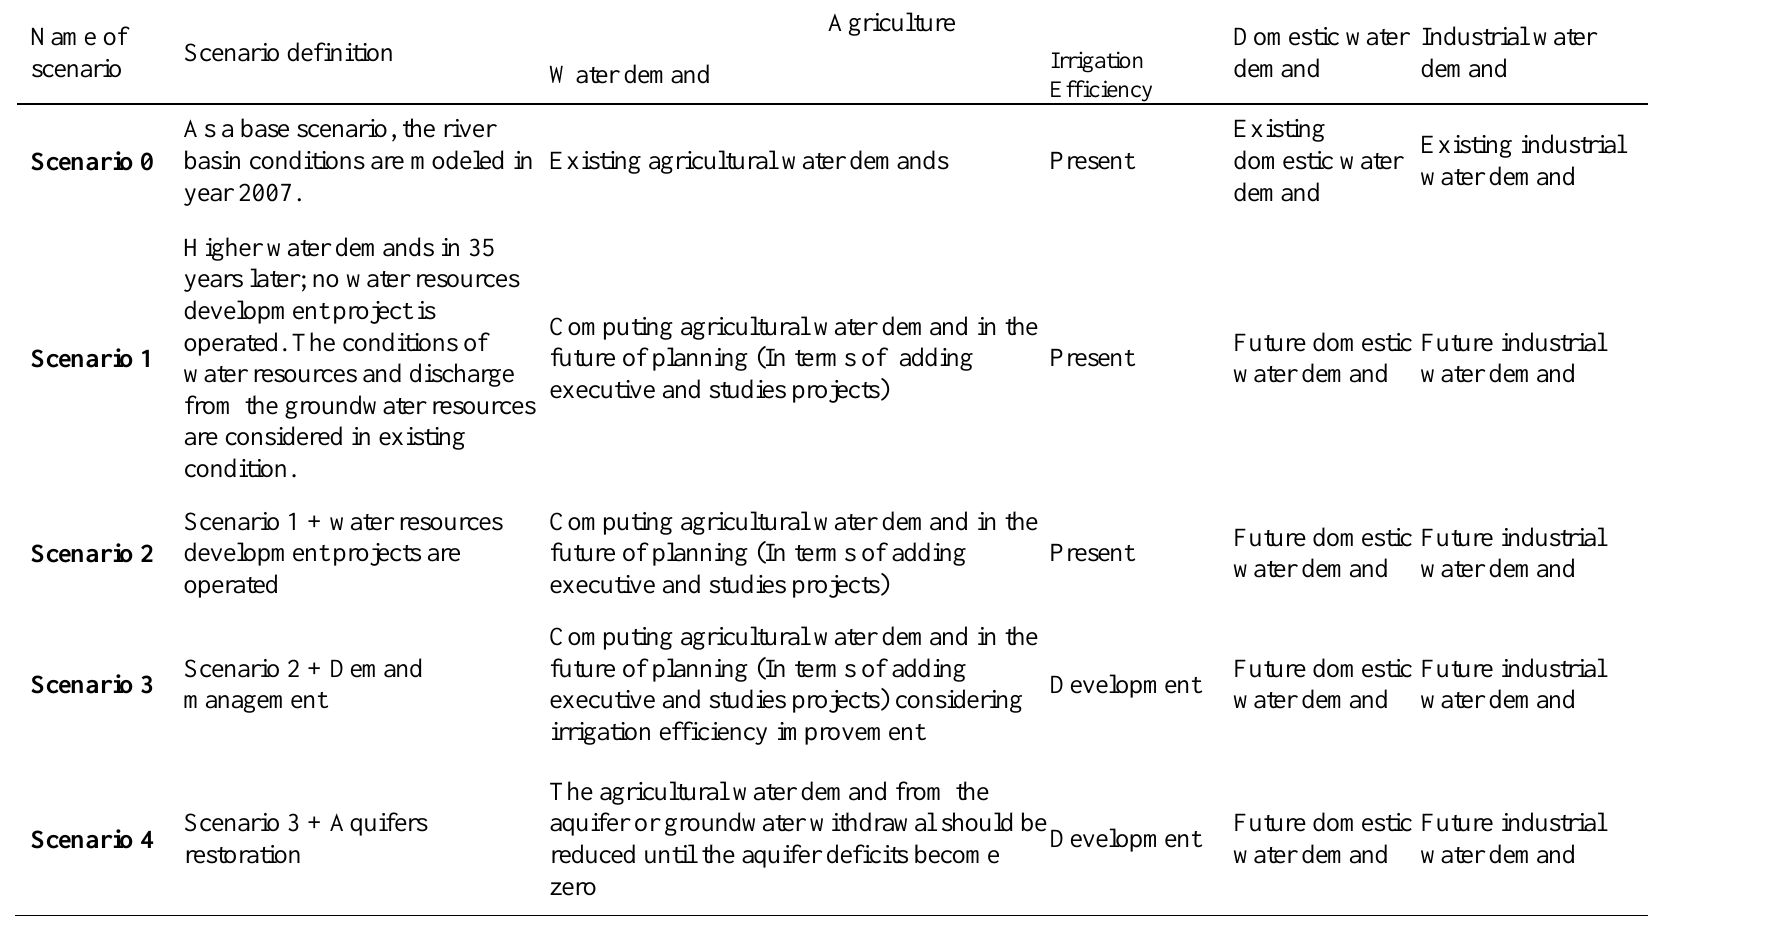
Table 2. Summary of water resources planning scenarios of Hamoon- Jazmorian basin area Name